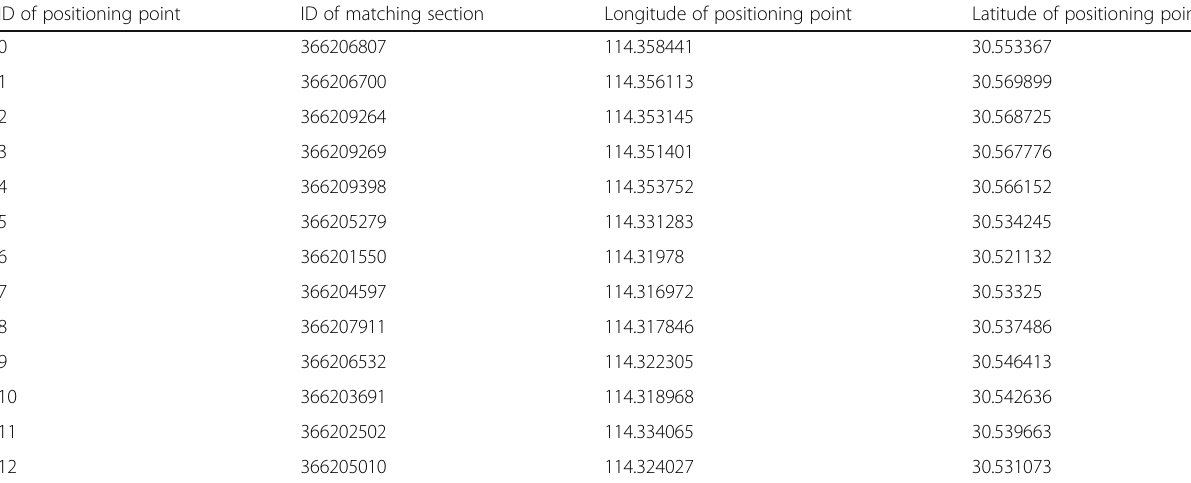
Table 2 Matching results of some positioning points ID of positioning